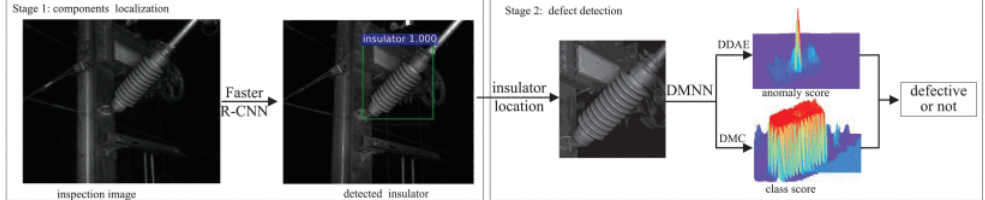
Figure 1. Workflow of catenary defect detection. Reproduced with permission from IEEE